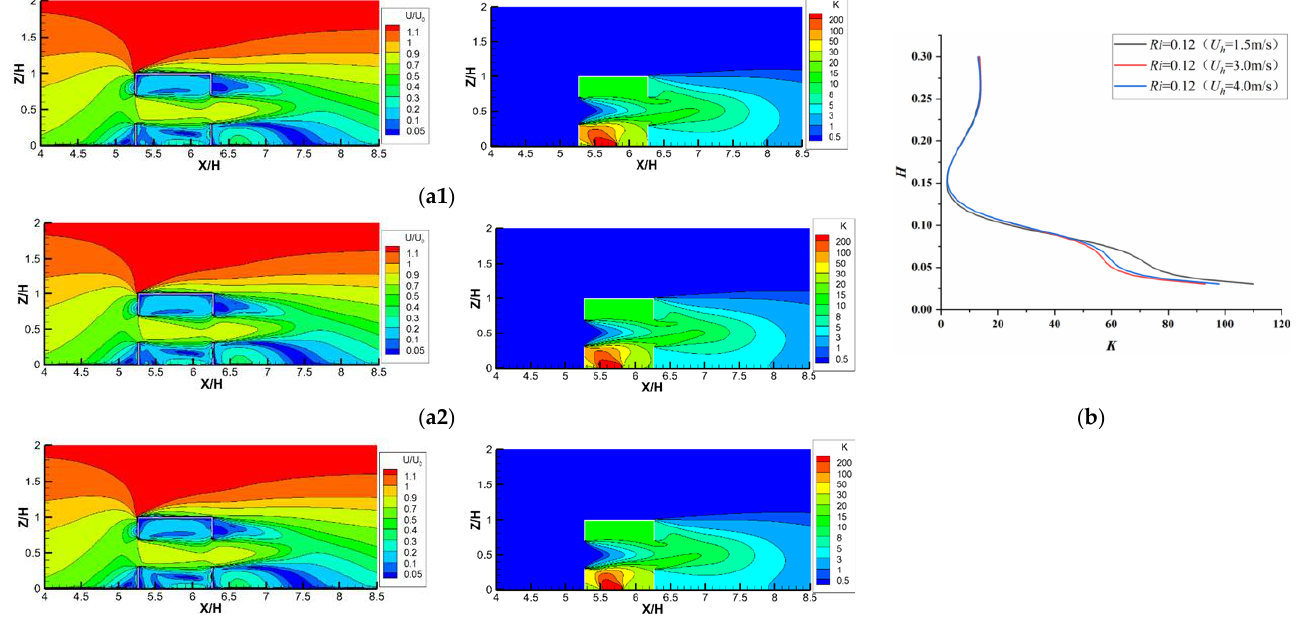
Figure 7. Comparison of U/U 0 and K values under the same Ri (= 0.27) with different Re for cross- ventilation. Contour plots under ( a1 ) Re w = 2.26 × 10 4 , Gr = 1.36 × 10 8 ; ( a2 ) Re w = 4.50 × 10 4 , Gr = 5.61 × 10 8 ); ( a3 ) Re w = 5.98 × 10 4 , Gr = 9.55 × 10 8 ; ( b ) K distributions along line A.